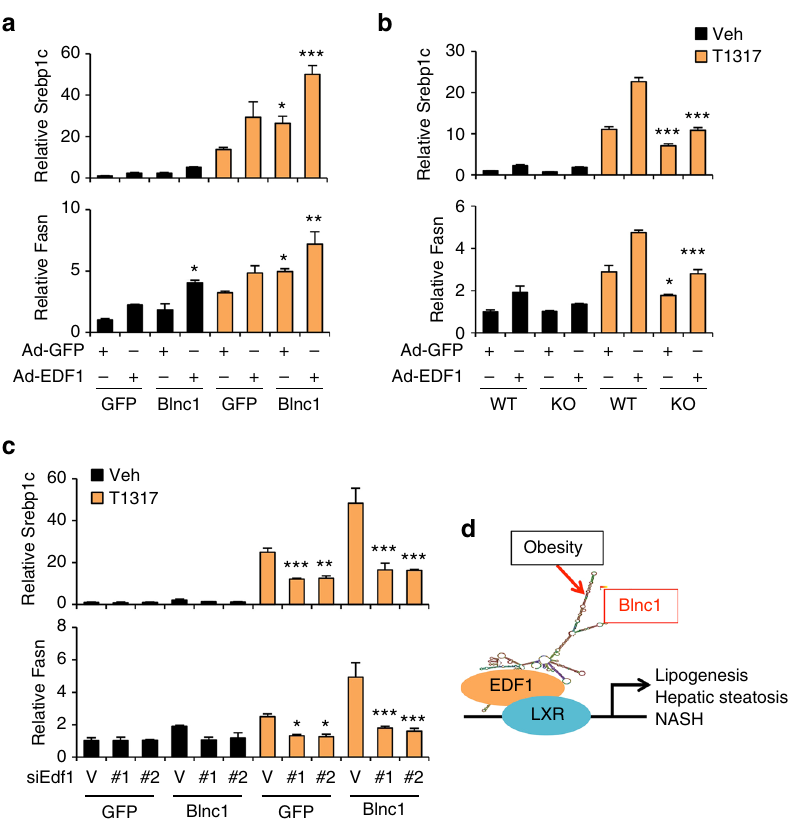
Fig. 10 Role of EDF1 in lipogenic gene regulation. a qPCR gene expression analyses in hepatocytes transduced with recombinant adenoviruses as indicated. Data represent mean ± SD ( n = 3). * p < 0.05, ** p < 0.01, *** p < 0.001, GFP vs. Blnc1, two-way ANOVA. b Gene expression analysis in transduced WT or Blnc1 KO hepatocytes. Data represent mean ± SD ( n = 3). * p < 0.05, *** p < 0.001, WT vs. KO, two-way ANOVA. c qPCR analysis of gene expression in transduced hepatocytes receiving control siRNA (V) or siRNAs targeting EDF1 (#1 and #2) followed by treatments with vehicle or 5 μ M T1317 for 24 h. Data represent mean ± SD ( n = 3). * p < 0.05, ** p < 0.01, *** p < 0.001, vector vs. #1 or #2, two-way ANOVA. d A model depicting licensing of hepatic lipogenesis and NAFLD progression by the LXR/EDF1/Blnc1 ribonucleoprotein transcriptional washing, RNA was extracted with Trizol, treated with RNase-free DNase, and analyzed by RT-qPCR. For reverse precipitation, StA-Blnc1 was precipitated from total lysates of transfected HEK293T cells using streptavidin agarose beads. Pro- teins associated with beads were analyzed by immunoblotting. For mass spectro- metry analysis, WT mice were transduced with GFP or StA-Blnc1 AAV virus. Liver nuclear extract was prepared for af fi nity puri fi cation of Blnc1-associated proteins using streptavidin agarose beads. Protein bands unique for StA-Blnc1 were excised for identi fi cation by mass spectrometry. For RNA IP assay, liver nuclear extracts were incubated with control IgG or antibodies speci fi c for YBX1 and EDF1 in the presence of protein A beads. Precipitated RNA was extracted using Trizol after three washes followed by RNase-free DNase treatment and subjected for RT-qPCR analysis. Luciferase reporter and ChIP assays . The Srebp1c promoter was ampli fi ed by PCR and cloned into pGL3-Basic vector. HEK293T cells in a 12-well plate were transiently transfected with Srebp1c -luc (50ng/well) and LXR α (100 ng/well), RXR β (100ng/well) in combination with Blnc1 (100ng/well), and two different doses of EDF1 (100 and 200 ng/well). Cells were harvested for luciferase assay 36h after transient transfection. All reporter assays were repeated at least three times in triplicates. For ChIP assay, chromatin extracts were prepared from WT and Blnc1 KO liver after T0901317 treatment for 4 days followed by preclearing and Table S2. Statistical analysis . Statistical analysis was performed using GraphPad Prism 7. Statistical differences were evaluated using two-tailed unpaired Student ’ s t -test for comparisons between two groups, or analysis of variance (ANOVA) and appro- priate post hoc analyses for comparisons of more than two groups. Two-way ANOVA with multiple comparisons was used for statistical analysis of ITT, GTT, and body weight studies. A p value of less than 0.05 (* p <0.05, ** p < 0.01, and